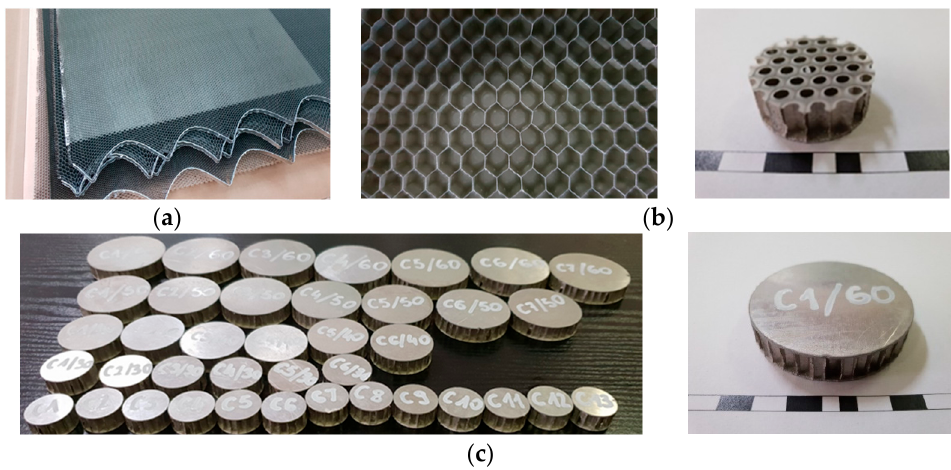
Figure 2. Tested honeycomb material: ( a ) semi-finished products for the production of samples; ( b ) process of joining cores with covers and checking quality of connection; ( c ) samples from series 3/6-5052-.001 prepared for testing.